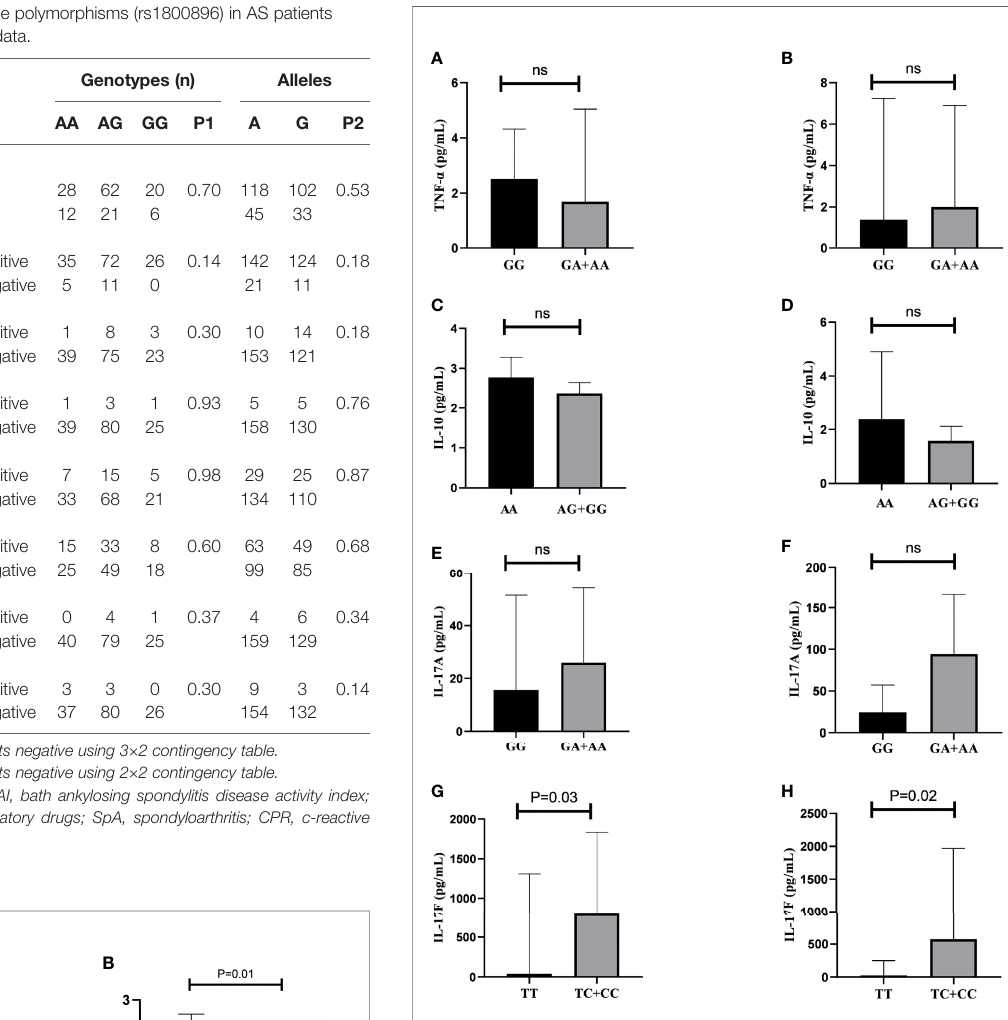
FIGURE 3 | Relation between serum cytokine levels and genotypes in AS patients and controls. (A) Comparison of TNF- a levels in patients with TNF rs1800629 G/G vs. G/A+AA genotypes. (B) Comparison of TNF- a levels in controls with TNF rs1800629 G/G vs. G/A+A/A genotypes. (C) Comparison of IL-10 levels in patients with IL10 rs1800896 A/A vs. A/G+G/G genotypes. (D) Comparison of IL-10 levels in controls with IL10 rs1800896 A/A vs. A/G+G/ G genotypes. (E) Comparison of IL-17A levels in patients with IL17A rs2275913 G/A+A/A vs. G/G genotypes. (F) Comparison of IL-17A levels in controls with IL17A rs2275913 G/A+A/A vs. G/G genotypes. (G) Comparison of IL-17F levels in patients with IL17F rs763780 T/C+C/C vs. T/T genotypes. (H) Comparison of IL-17F levels in controls with IL17F rs763780 T/C+C/C vs. T/T genotypes; ns, not signi fi